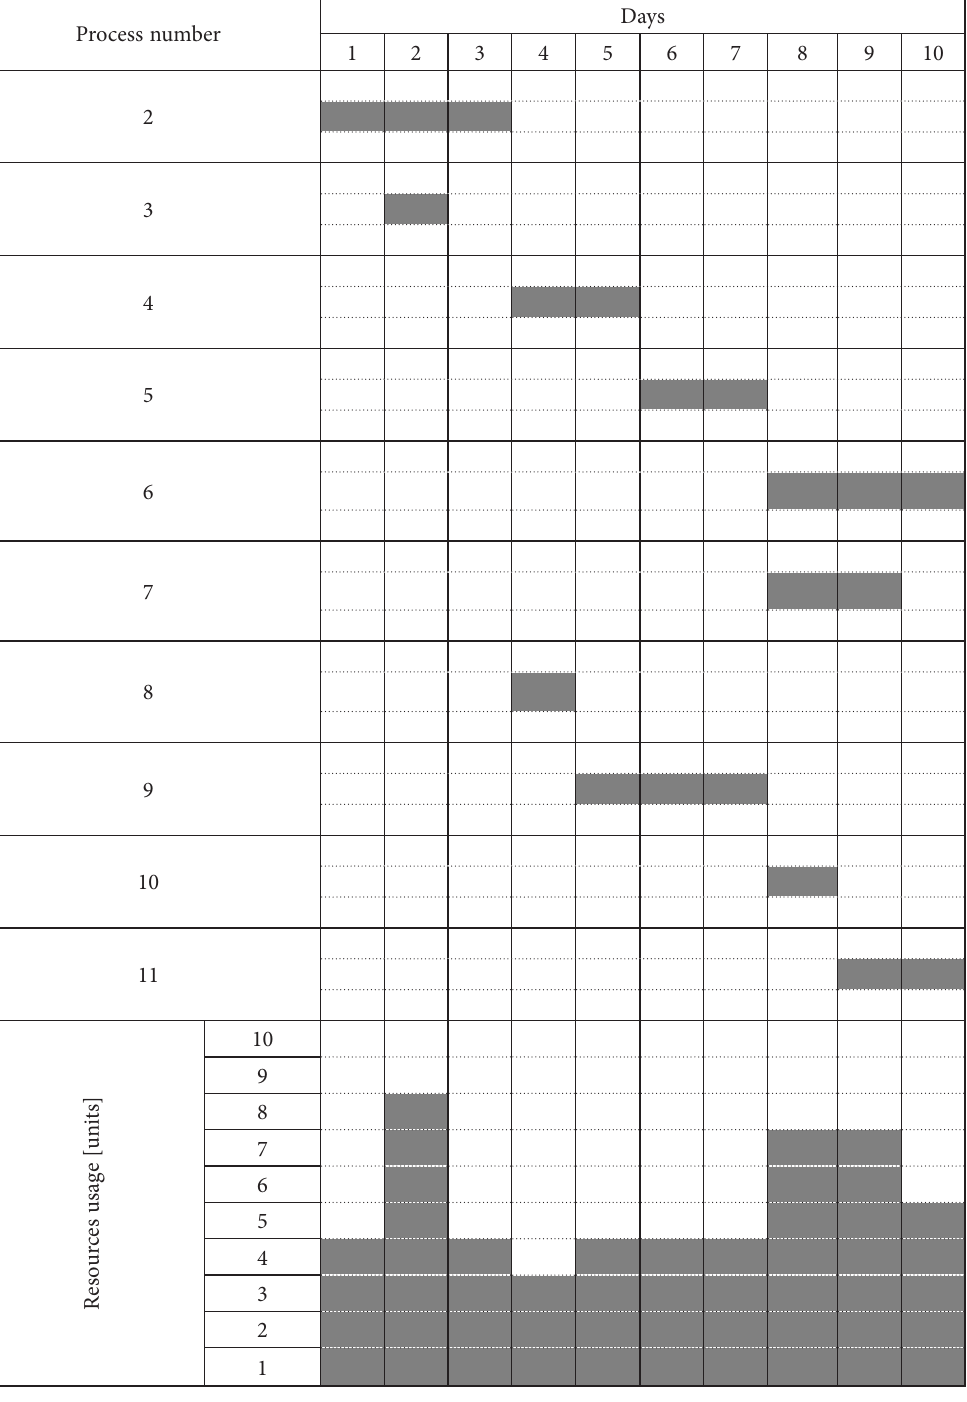
Figure 2. Project schedule and the optimal resource utilization profile (weakening soft precedence relation not